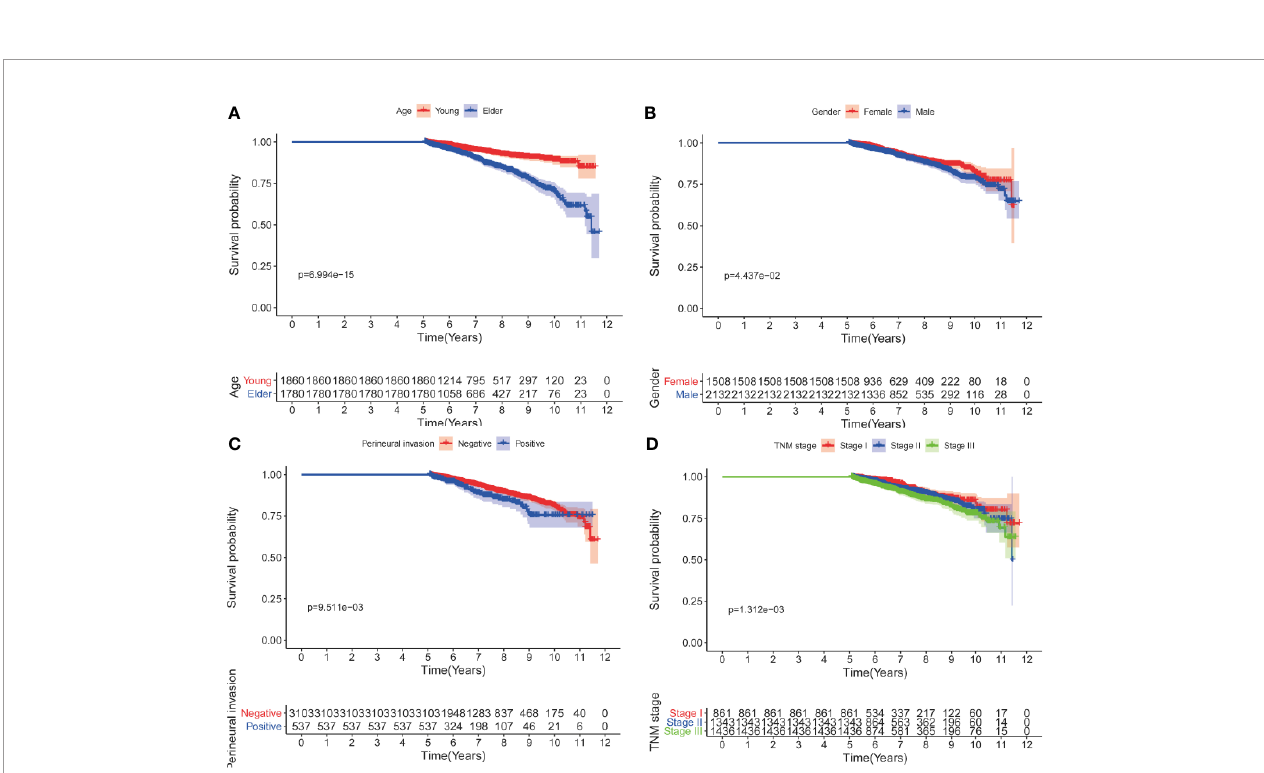
FIGURE 2 | Kaplan-Meier curves for OS after fi ve years according to clinicopathological factors. (A) age; (B) gender; (C) perineural invasion; (D) pathological